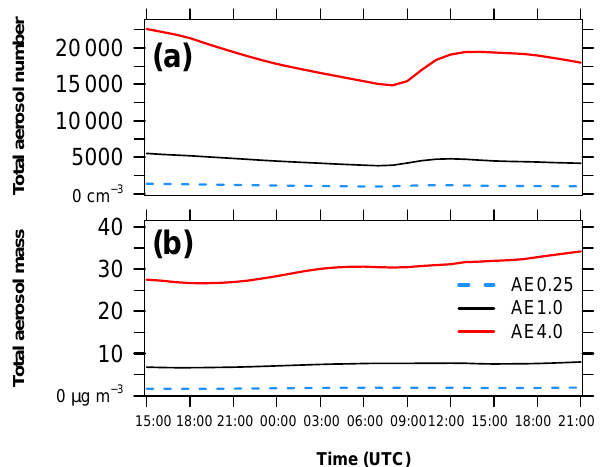
Figure D1. Temporal evolution of median (a) total aerosol number (cm − 3 ) and (b) total aerosol mass (µgm − 3 ) in the lowest 2kma.g.l. over Ivory Coast (7.5–3.0 ◦ W) between 2 July 15:00UTC and 3 July 21:00UTC for the clean (blue dashed), reference (black solid) and polluted case (red solid) based on the aerosol scaling introduced in Table 1.